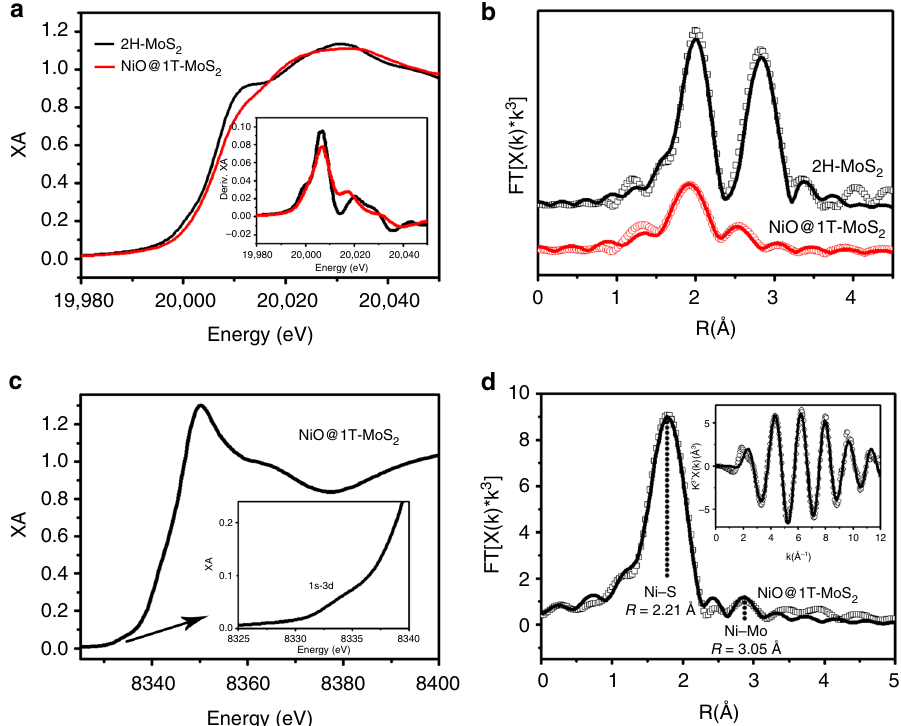
Fig. 3 X-ray absorption analysis. a The normalized Mo K-edge XANES spectra and fi rst derivative inset. b Comparison of R-space data and best fi t lines. c Ni K-edge XANES spectrum for NiO@1T-MoS 2 with enlarged pre-edge region inset. d Corresponding EXAFS spectrum fi tting of NiO@1T-MoS 2 in R-space with K-space inset